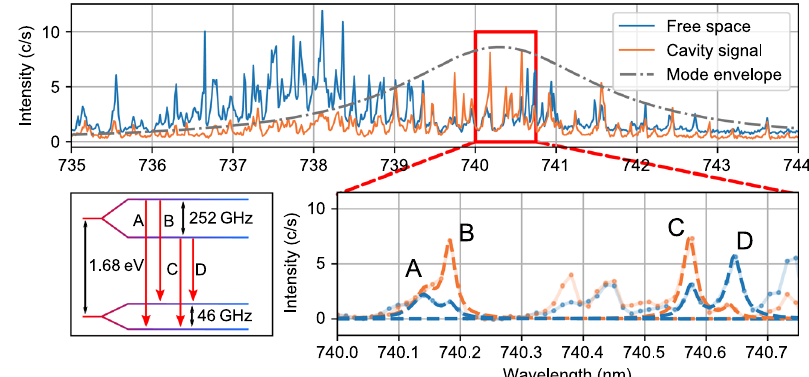
zoom of the area in the red rectangle and sketched on the right) of the SiV − center are referenced to the lines according to their